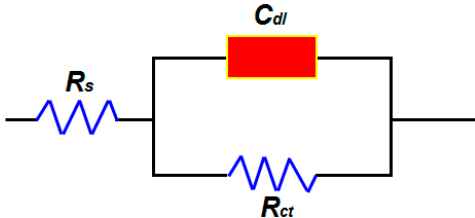
Figure 6. Equivalent circuit model.